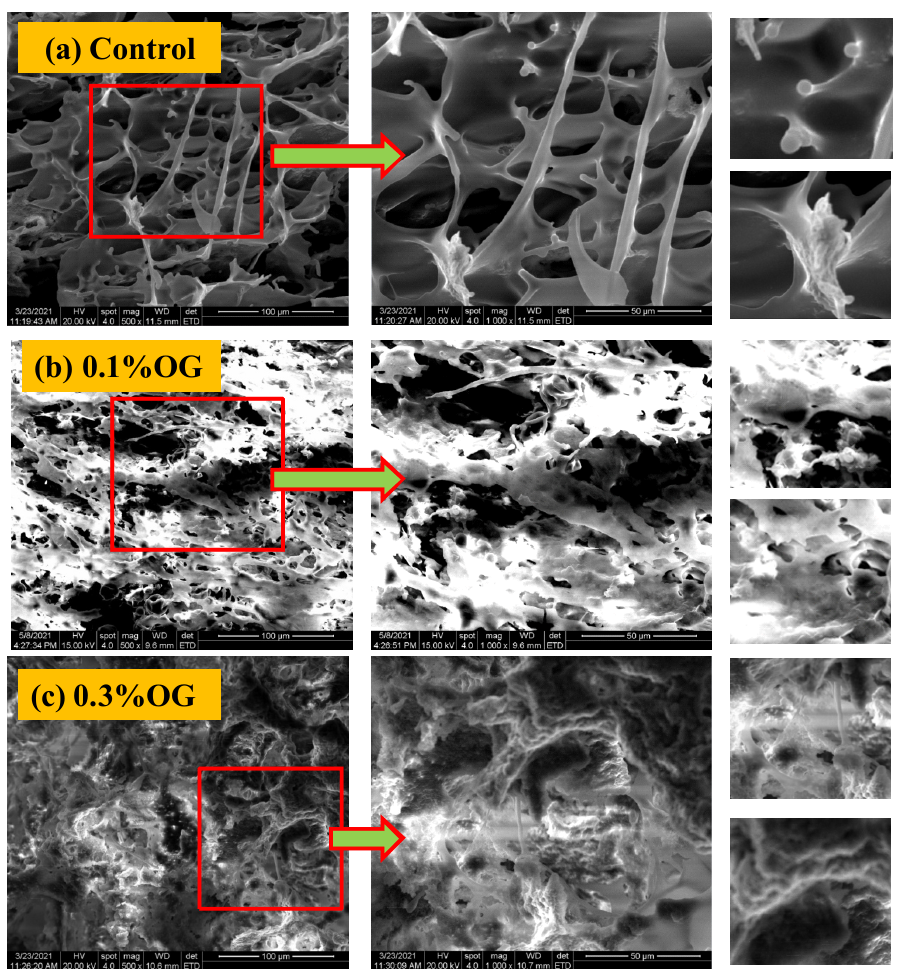
Figure 6. SEM of set-type yogurt before and after adding OG: ( a ) SEM of set-type yogurt without OG addition; ( b ) SEM of set-type yogurt with 0.1% OG; ( c ) SEM of set-type yogurt with 0.3% OG.